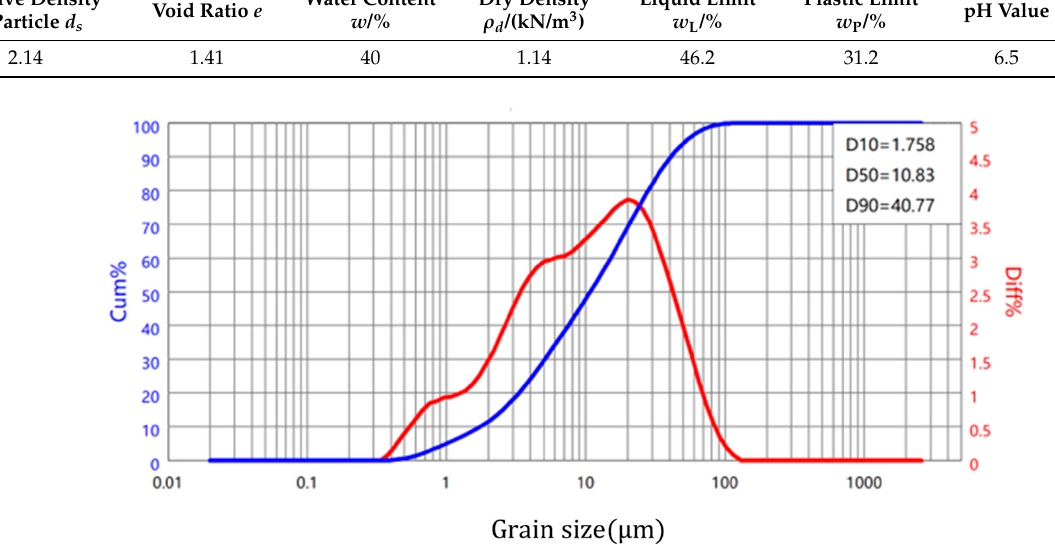
Figure 1. Particle size distribution curve of soil.